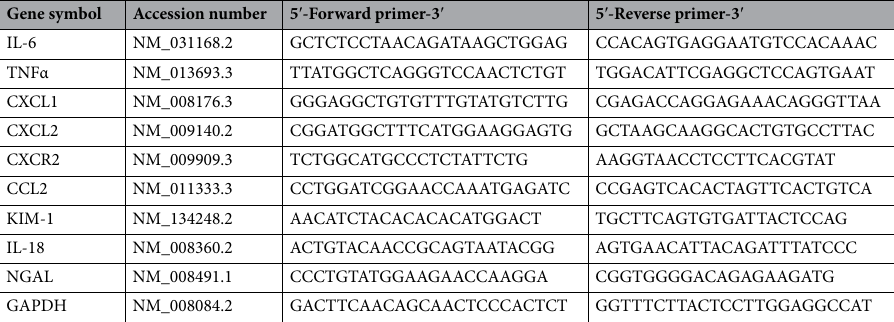
Table 1. Primers used for quantitative RT-PCR. RT-PCR reverse transcription polymerase chain